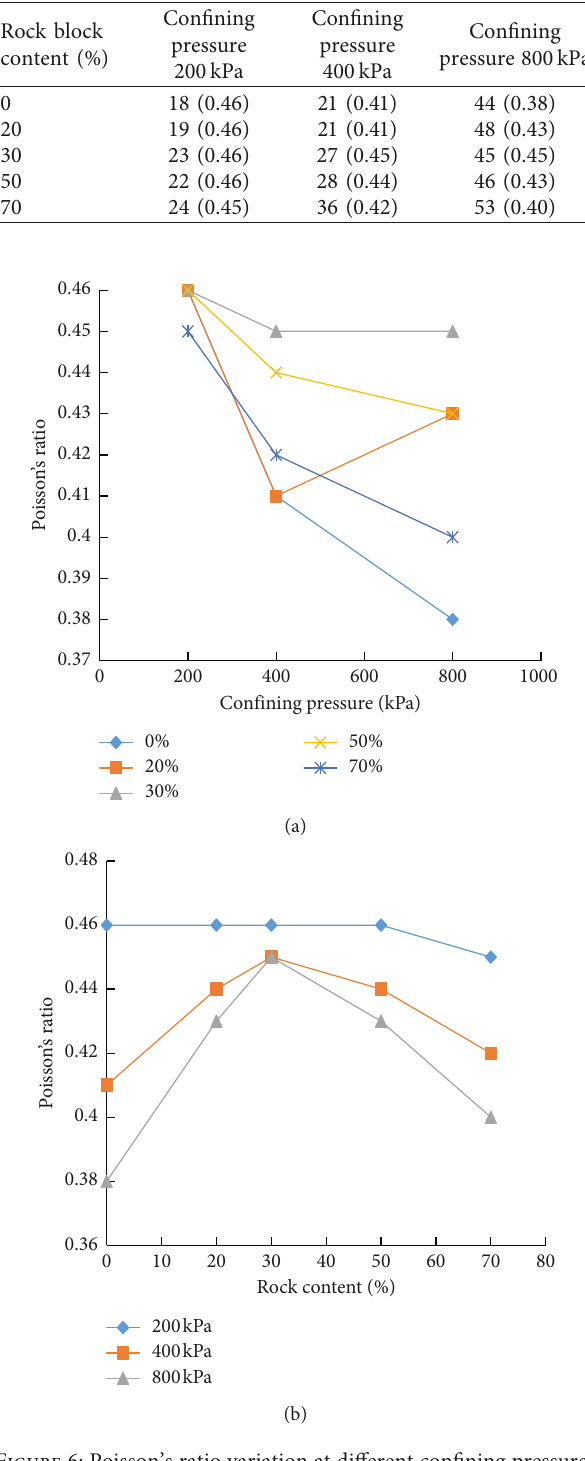
Table 5: Elastic modulus and Poisson’s ratio (in brackets) of rock content mixtures and variable confining pressures.